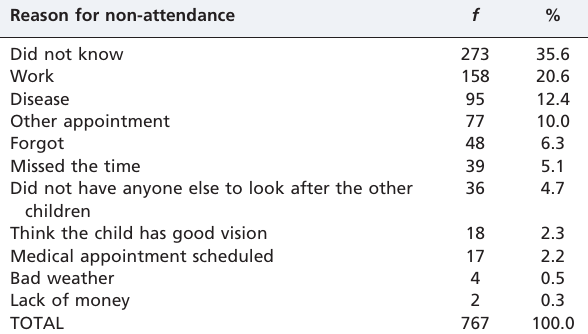
Table 3 - Reason for not attending the first